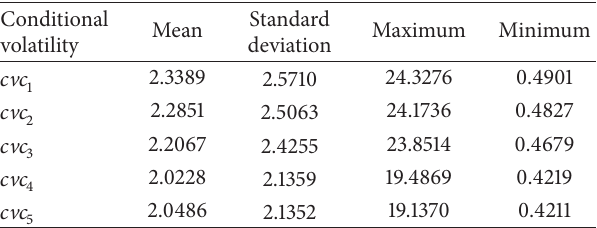
Table1:Statisticaldescriptionofconditionalvolatilitywithdifferent maturities disturbed from futures market ( ×10 −4 ).